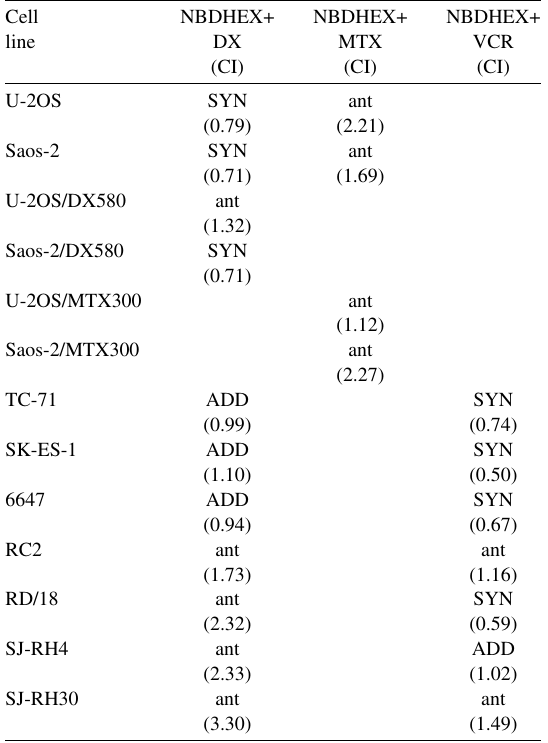
Effects of the in vitro simultaneous administration of NBDHEX and doxorubicin (DX), methotrexate (MTX), or vincristine (VCR) in humanosteosarcoma,Ewing’ssarcomaandrhabdomyosarcomacell lines